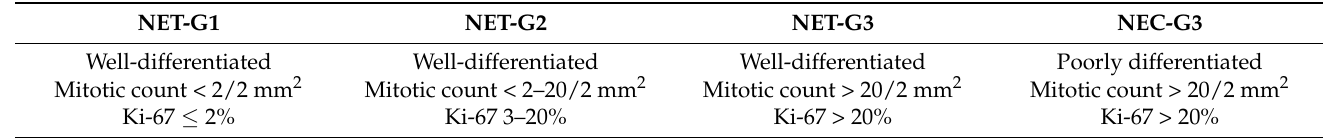
Table 1. The World Health Organization 2017 classification for neuroendocrine